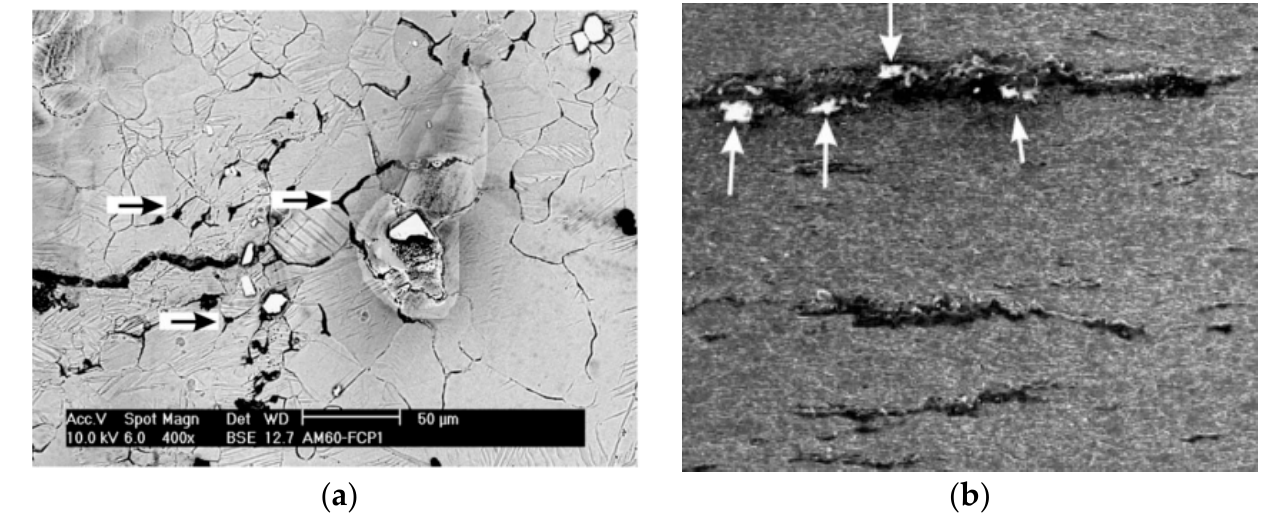
Figure 1. Influence of microstructure on advent and propagating microcrack “Reused with permission from Elsevier by License No. 5494601058390” [36]; ( a ) The crack tip of extruded AM60 at a high ∆ K; ( b ) The macro-cracks near oxide and Al–Mn particles.